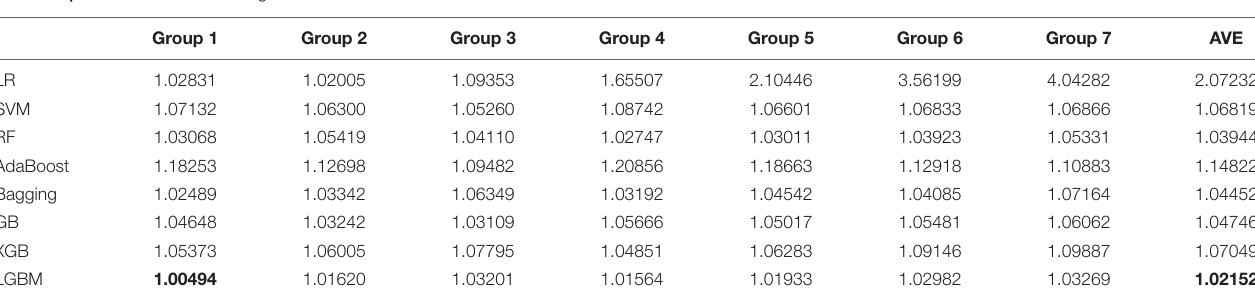
TABLE 6 | Relaxation model training MAE results.